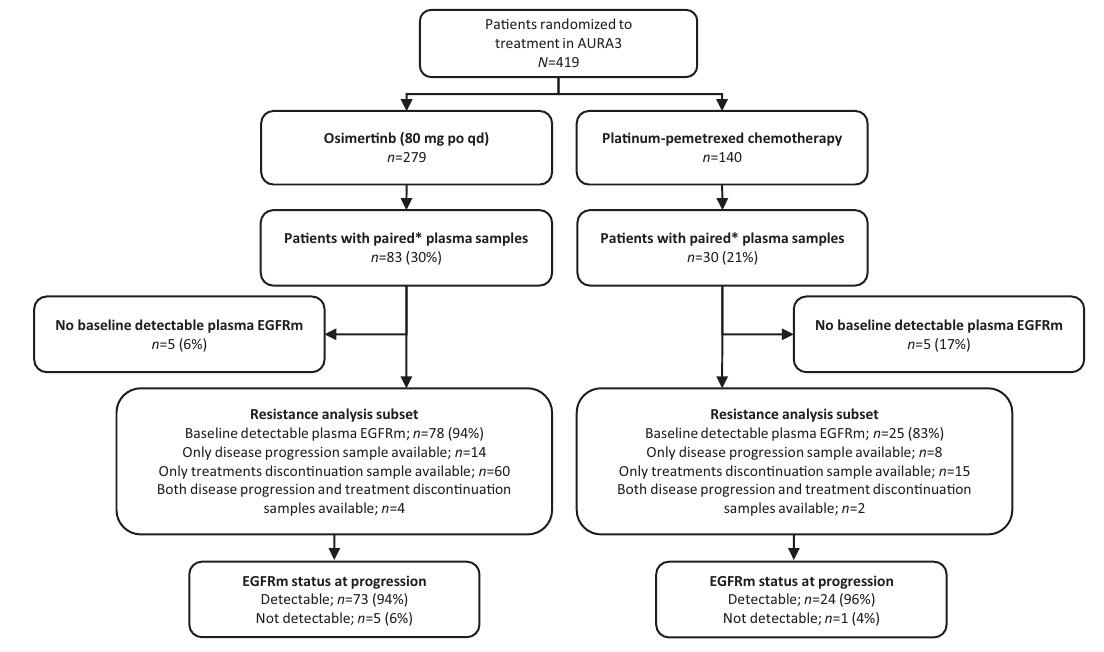
Fig. 1 | Patient disposition. CONSORT fl ow diagram of patient disposition and eligibility in the analysis of mechanisms of acquired resistance in the AURA3 trial. *Plasma provided at baseline and at disease progression or treatment